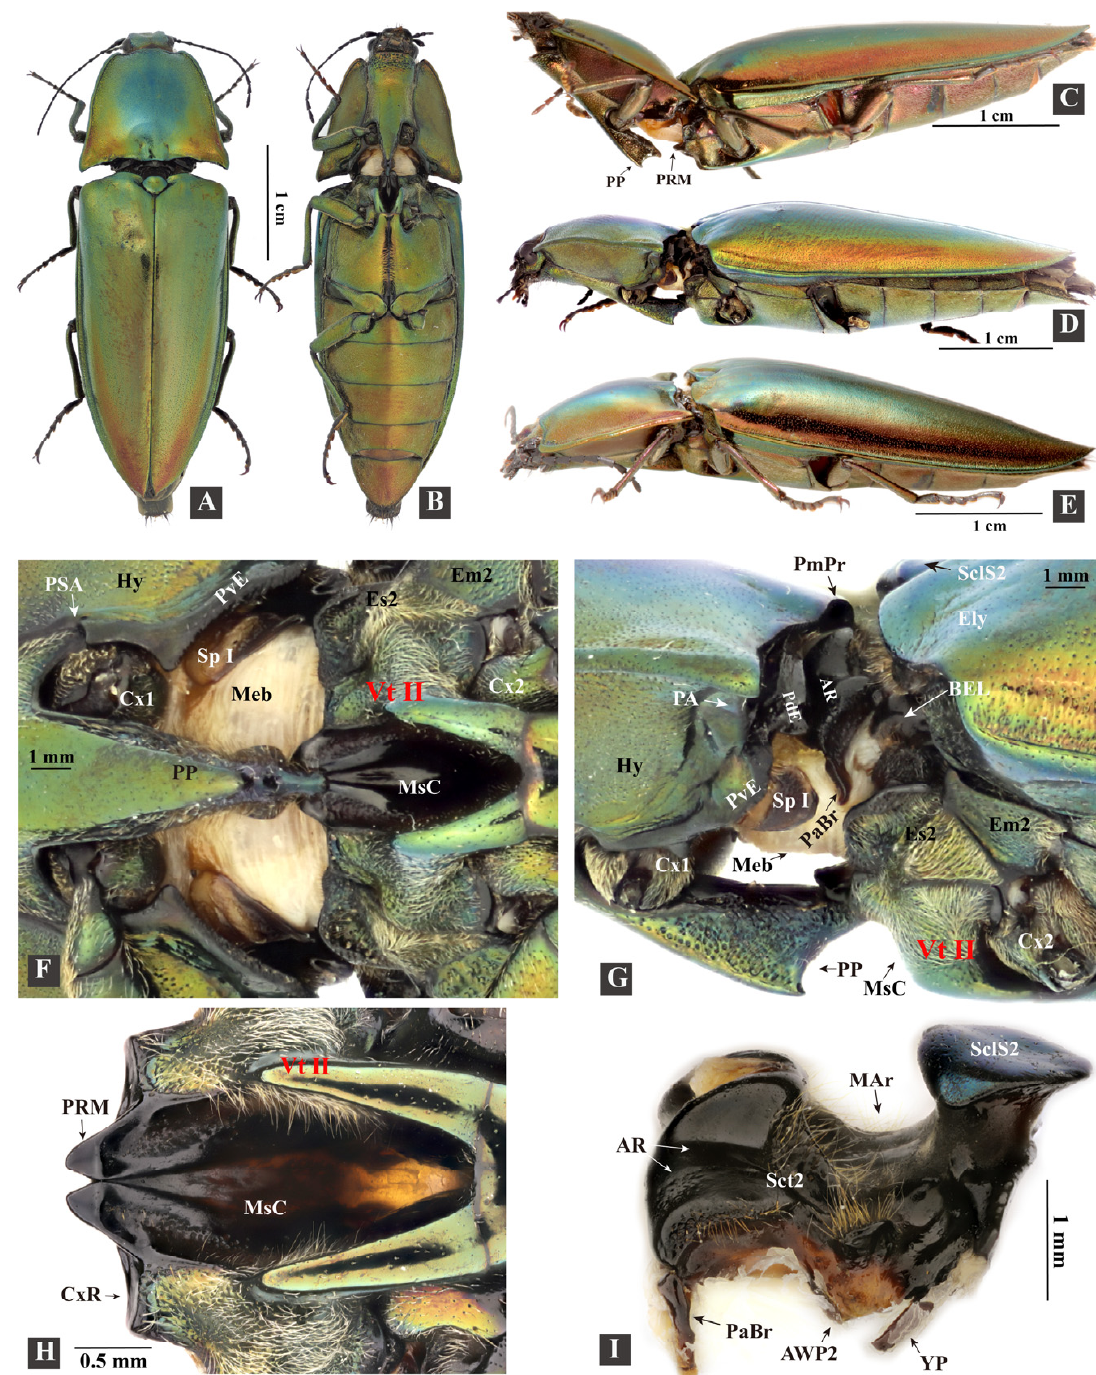
Figure 1. Habitus and exoskeleton of Campsosternus auratus . See Section 2 ‘Materials and Methods’ for abbreviations. ( A ) dorsal view, resting position. ( B ) ventral view, latching position; the prosternal process (PP) is latched onto the prosternal rest of the mesoventrite (PRM). ( C ) lateral view of a live individual in a back-arched position preparing to latch onto the PP and PRM. ( D ) lateral view of a specimen in latching position, PP is latched onto the PRM. ( E ) lateral view of a live individual in resting position. ( F ) ventral view of promesothoracic gap, zoomed-in from inset ( B ). ( G ) lateral view of promesothoracic gap, zoomed-in from inset ( D ); Meb indicates the promesothoracic intersegmental membrane. ( H ) ventral view of the mesoventrite. ( I ) lateral view of the